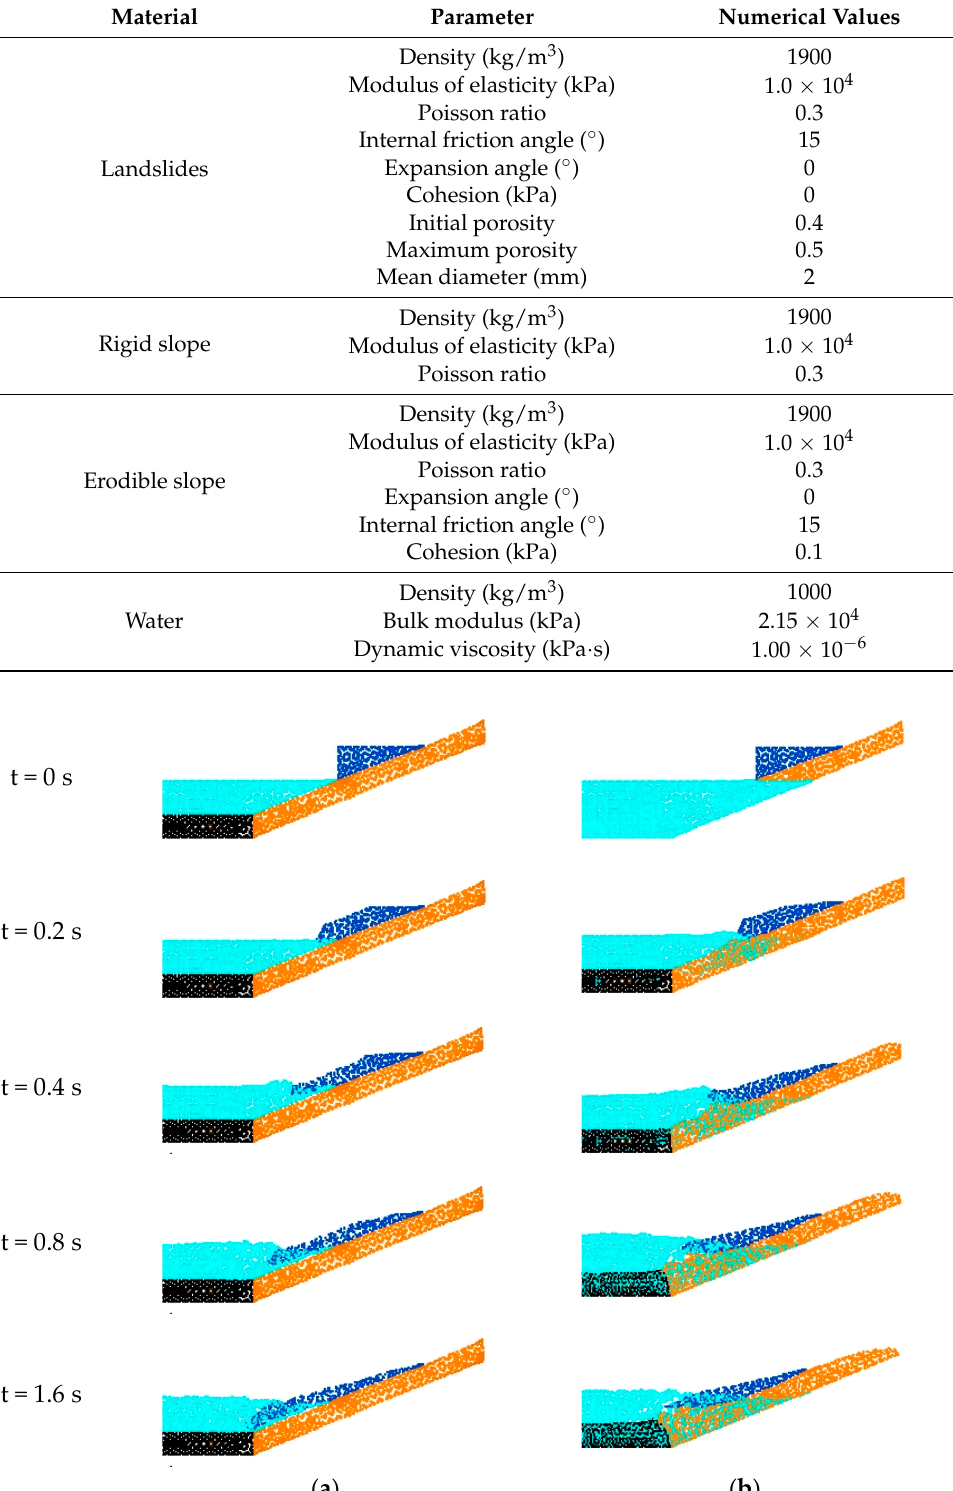
Table 2. Material parameter.